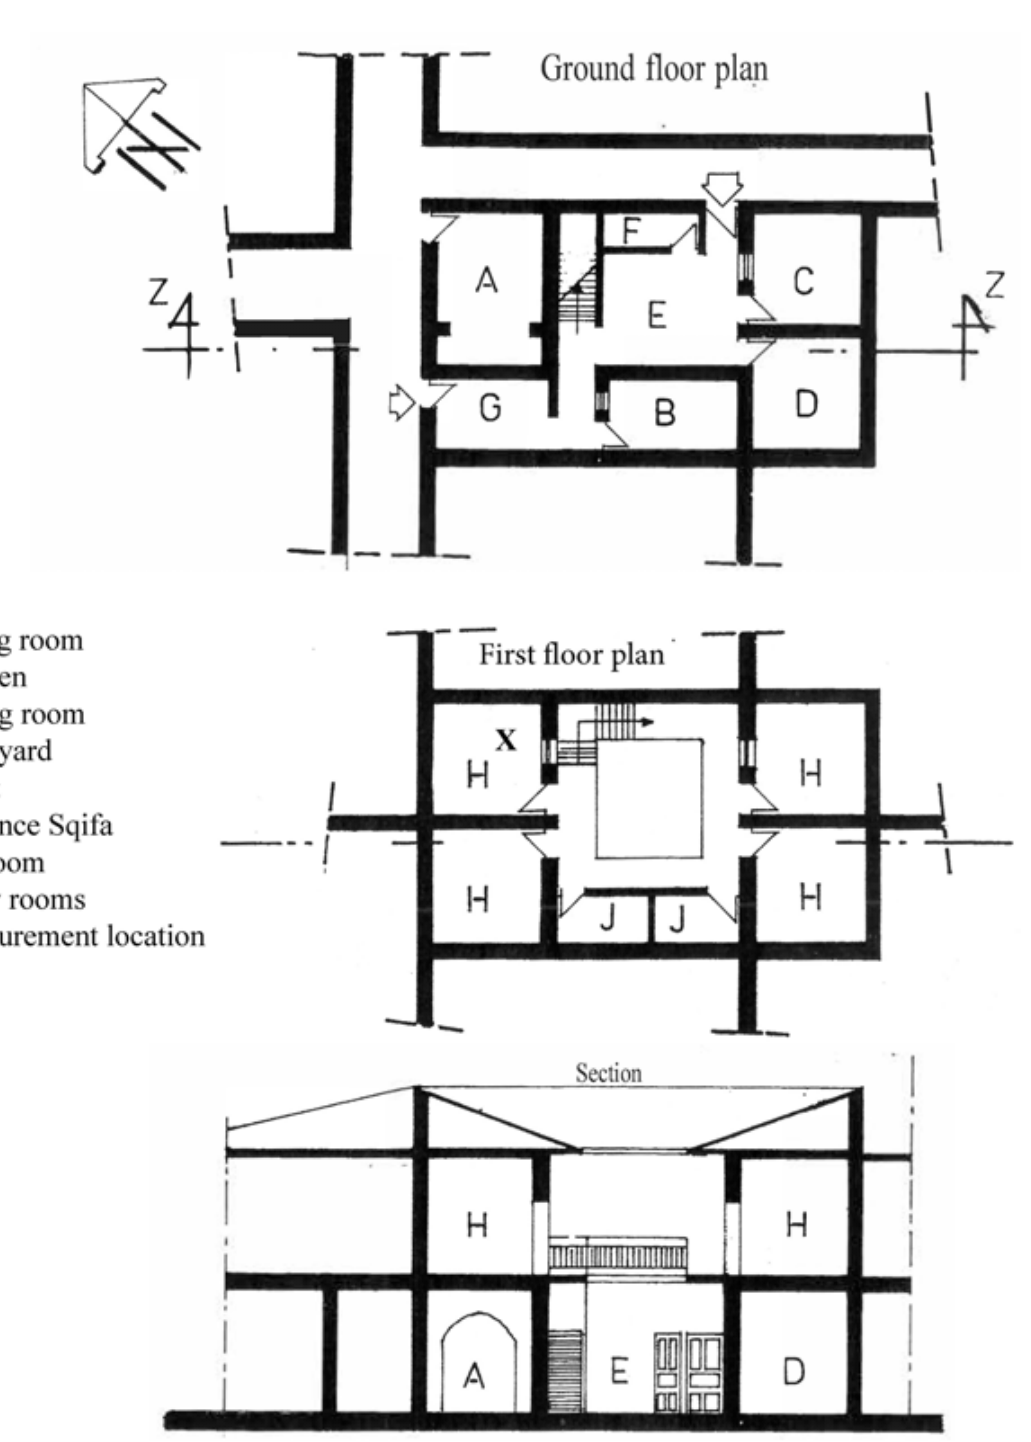
Figure 12. Plansand section of the Boussaada house. Source: The Author (2016)